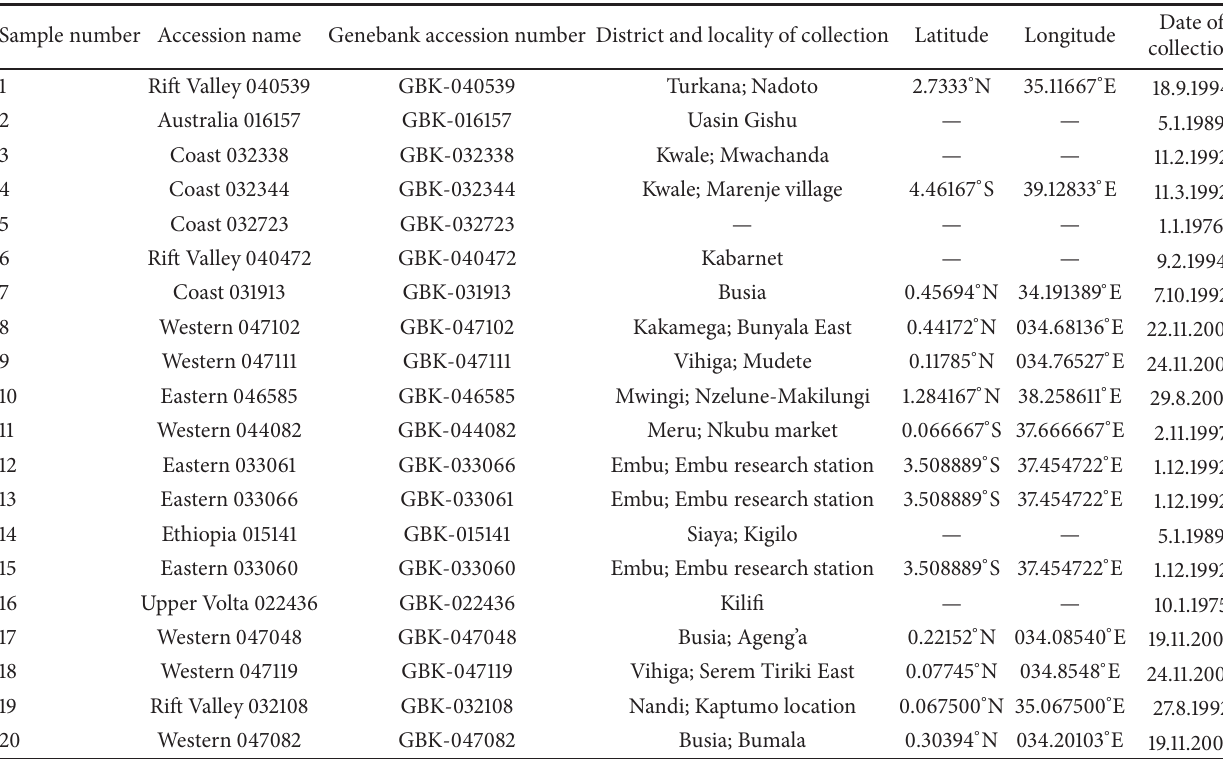
Table 1: List of the names of all 19 cowpea accessions used in this study and their geographic distributions (locations).